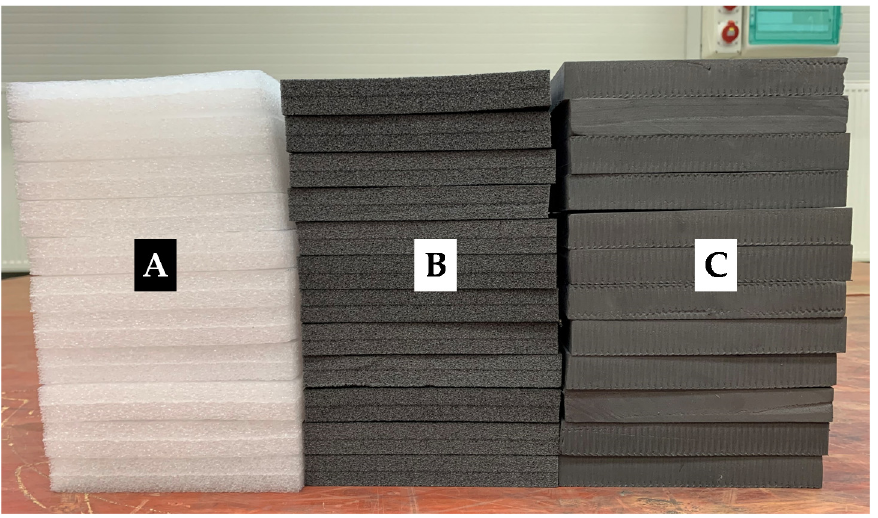
Figure 3. Samples used in this study. ( A ) PE25, ( B ) PE30, and ( C )